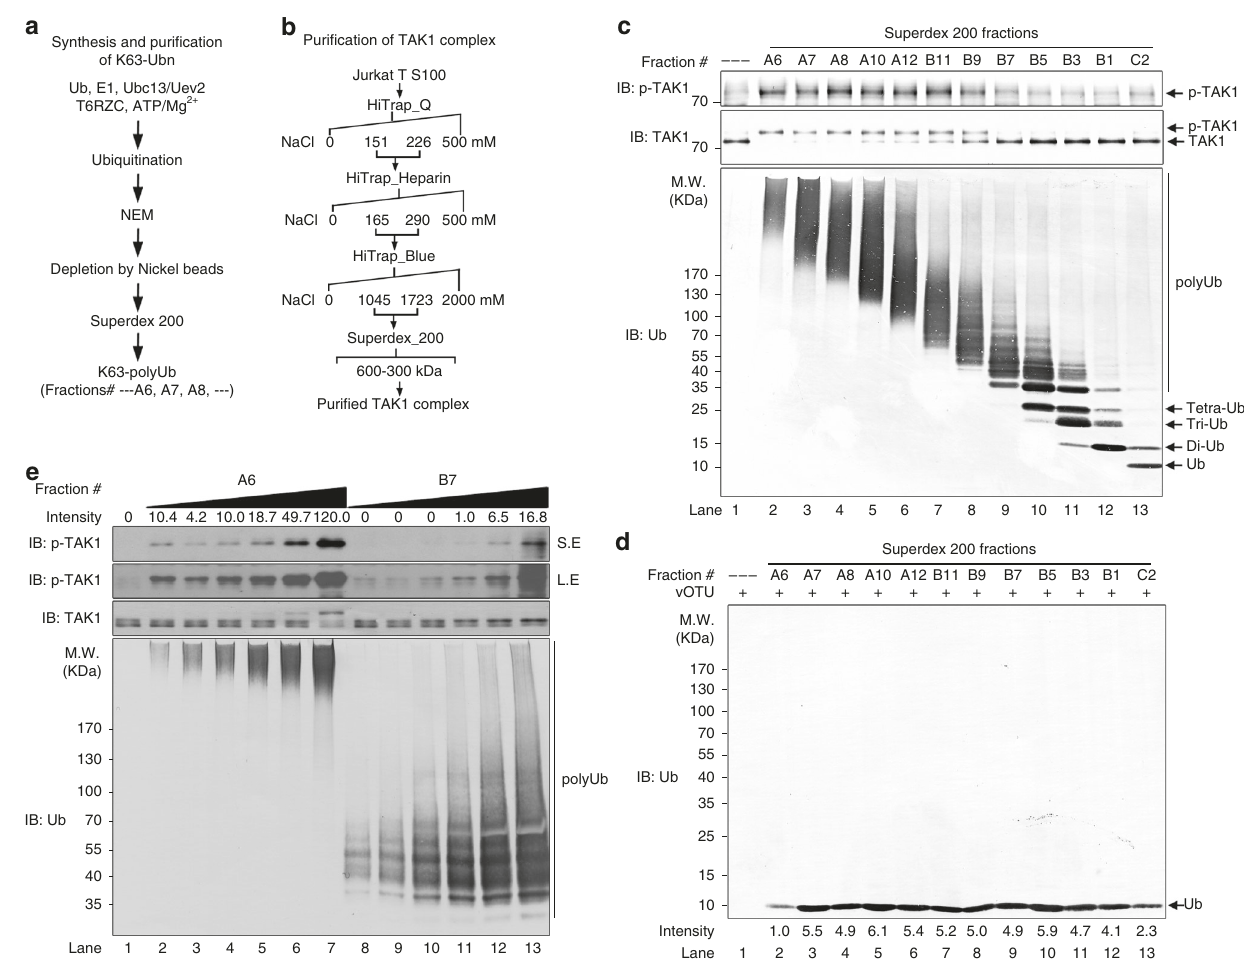
Fig. 1 Only long free polyubiquitin chains potently activate TAK1 kinase. a Puri fi cation scheme of polyubiquitin (polyUb) chains. b Puri fi cation scheme of endogenous TAK1 kinase complex. c Potent TAK1 activation by high molecular size polyUb chains. Partially puri fi ed TAK1 complex as in b was incubated with different sizes of polyUb chains after their fractionation as in a in the presence of ATP for 60 min at 30 °C. Aliquots of the reaction products were analyzed by immunoblotting with the indicated antibodies. The size distribution of the polyUb chains is shown in the bottom panel. d The relative amounts of polyUb chains used in c were determined by immunoblotting with anti-Ub antibody after their complete disassembly by DUB vOTU. e The chain length rather than the concentration of polyUb chains contributes more to TAK1 stimulatory activity. As in c , TAK1 was incubated with increasing amounts of long polyUb chains (Fraction A6) or short polyUb chains (Fraction B7) to determine its dose response to polyUb chains. S.E. short exposure, L.E. long